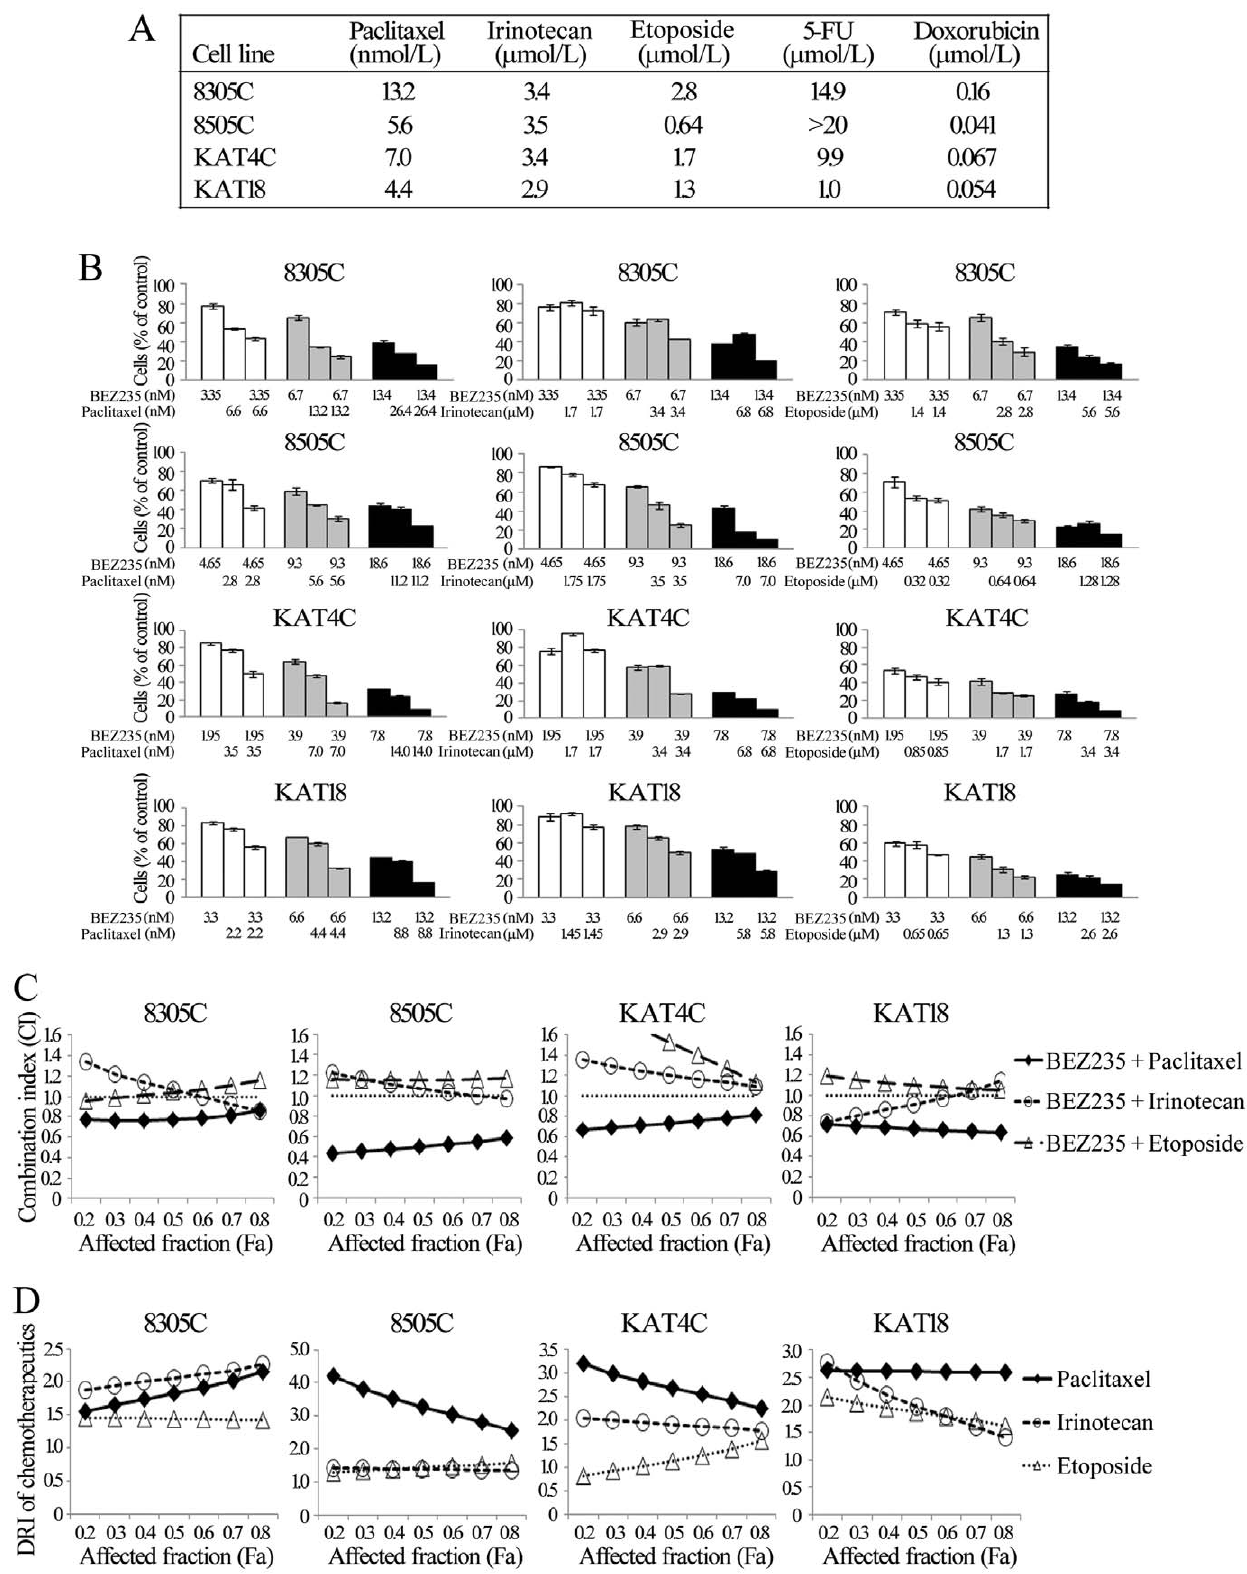
Figure 6. Combination therapy of BEZ235 with paclitaxel has synergistic effects against ATC. A, Dm was calculated using cytotoxicity data using CompuSyn software for each drug on each cell line at day 4. B, the cytotoxic effects of BEZ235 and chemotherapeutic agents (paclitaxel, irinotecan and etoposide) alone or in combination after a 4-day treatment in ATC were evaluated using LDH assays. The combination of BEZ235 and